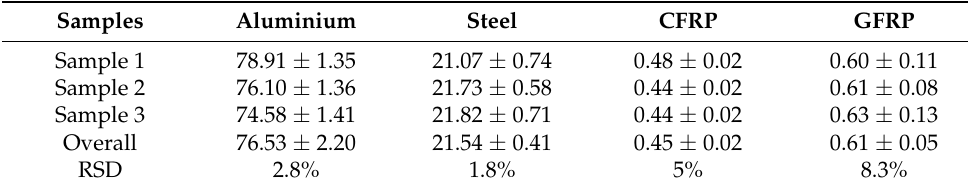
Table 4. Measured thermal diffusivity (mm 2 /s) values with RSD for multiple samples using the NLSF